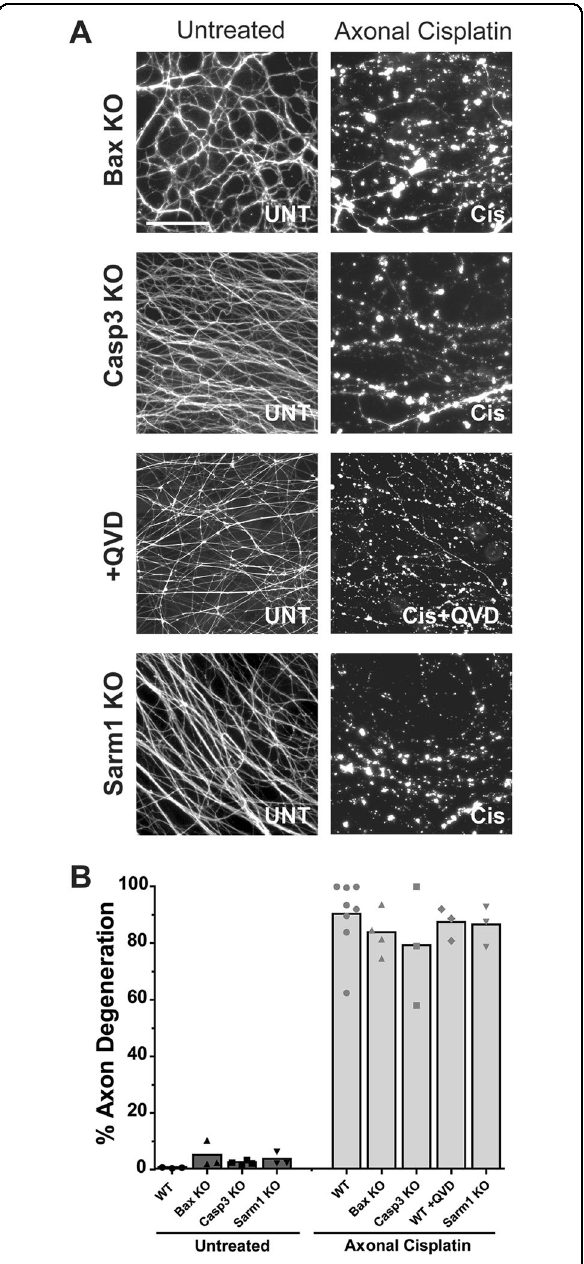
Fig. 5 Cisplatin-induced axon degeneration is not mediated by the known pathways of axon degeneration. A Neurons were isolated from mice, either wildtype or those de fi cient in Bax, Casp3, and Sarm1 and cultured in micro fl uidic chambers and either left untreated (UNT) or treated with cisplatin applied only to the axon chamber (Axonal Cisplatin; 20 µM) for 120 h and stained for tubulin. For the + QVD condition, wildtype neurons were cultured as described and treated with cisplatin applied only to the axon chamber in the presence of the pan-caspase inhibitor QVD (20 μ M Cis + 25 μ M QVD) for 120 h and stained for tubulin. The scale bar here depicts 100 μ m . B Quanti fi cation of the axon degeneration described in A ( n ≥ 3), individual data points and mean are